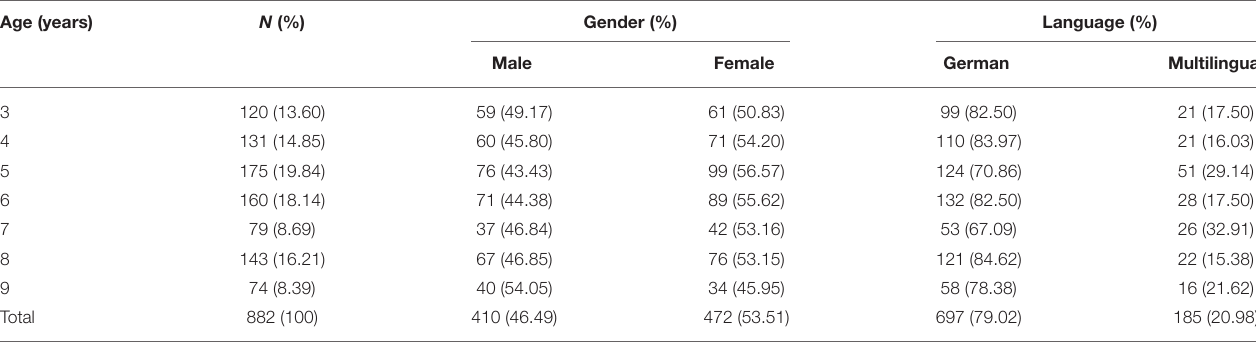
TABLE 3 | Sample characteristics of the norm sample of the ATEM